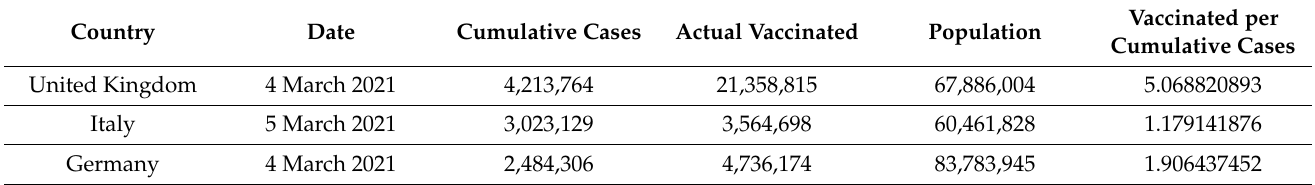
Table 7. Actual vaccinated people in second category countries [14].